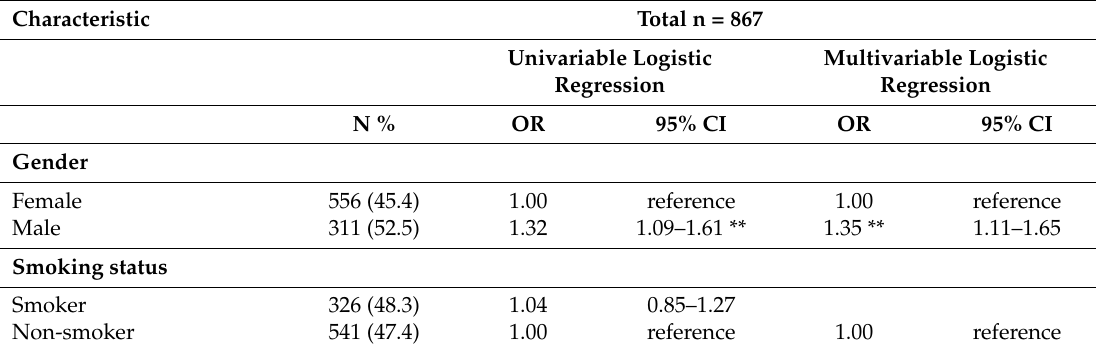
Table 3. Odds ratio (OR) and 95% confidence interval (CI) for inactivity during leisure time by socio-demographic